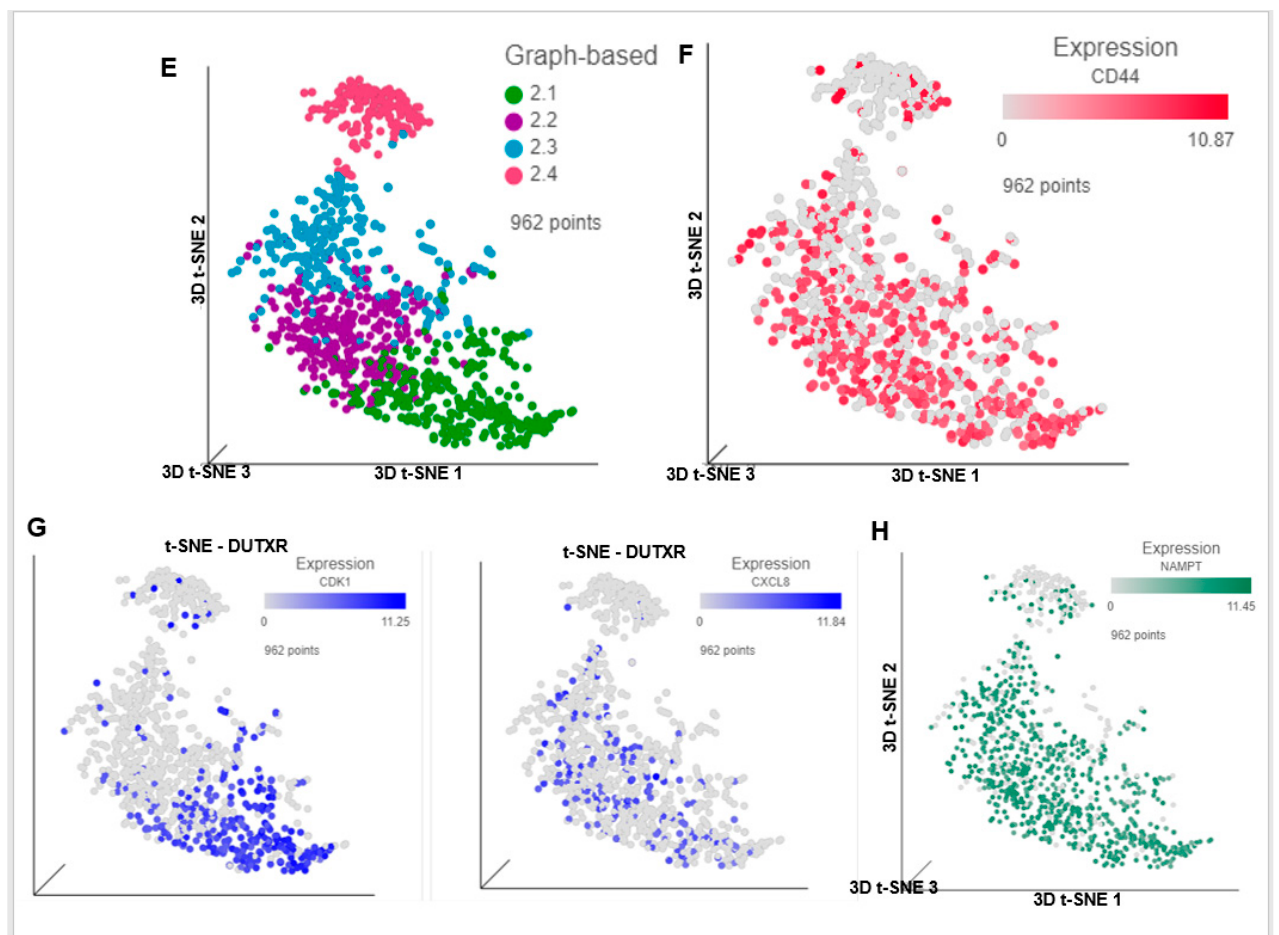
Figure 2. Comparison of single-cell RNAseq data between DU145 and DUTXR. ( A ) All 4 t-SNE clusters, ( B – D ) showing the EMT markers TGF-B1, VIM and E-Cadherin (CDH1). ( E ) scRNAseq data shows DUTXR cells representing enrichment of gene signatures of ( F ) Cancer stemness CD44 high ; ( G ) Drug resistance (CDK1 high ; CXCL8 high ), and the ( H ) FK866 target NAMPT high . Each dot represents a single cell. Contaminated (doublet) cells were not included.